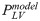
Two steps of the identification process.Step 1 consists in the minimization of Jstep1 for the identification of {XLV, Xart} from invasive LV pressure and non-invasive arterial pressure. Step 2 consists in the minimization of Jstep2 for the identification of {Xart} from non-invasive arterial pressure. Finally, PLVmodel is estimated for each patient from X¯LV* and Xart*.